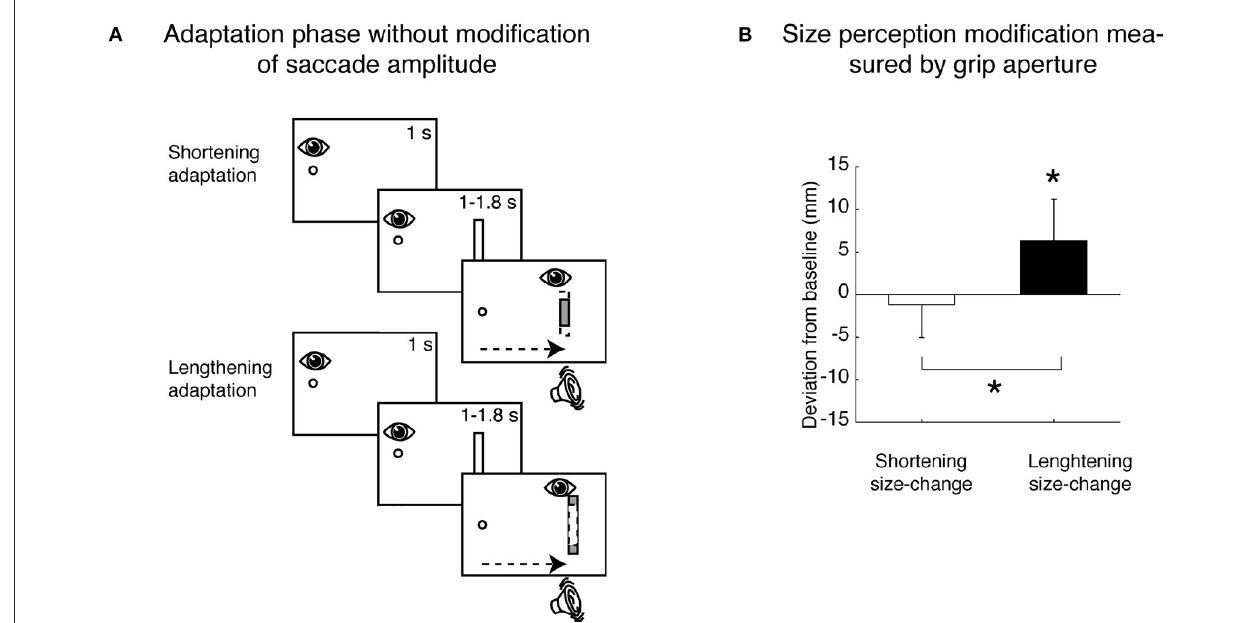
FIGURE5 Size perception modification not induced by saccadic adaptation. (A) Top row, Shortening adaptation condition. The fixation point was presented at the start of the trial. After 1s, a bar appeared, but participants had to continue to focus on the fixation target. After a randomized time, an acoustic signal indicated the possibility of executing a saccade toward the bar. Then the bar was symmetrically decreased in size by 30% of its length as soon as the saccade was detected. Bottom row, Lengthening adaptation. This was identical to the shortening adaptation, with the only difference being that the bar was symmetrically increased in size by 30% during the execution of the saccade. (B) Mean deviation of size perception (grip aperture) from baseline for the shortening (white column) and the lengthening (black column) adaptation trials. The data were averaged across participants and sizes. Details as in Figure 4 (modified from Bosco et al., 2020). * p < 0.05, significance